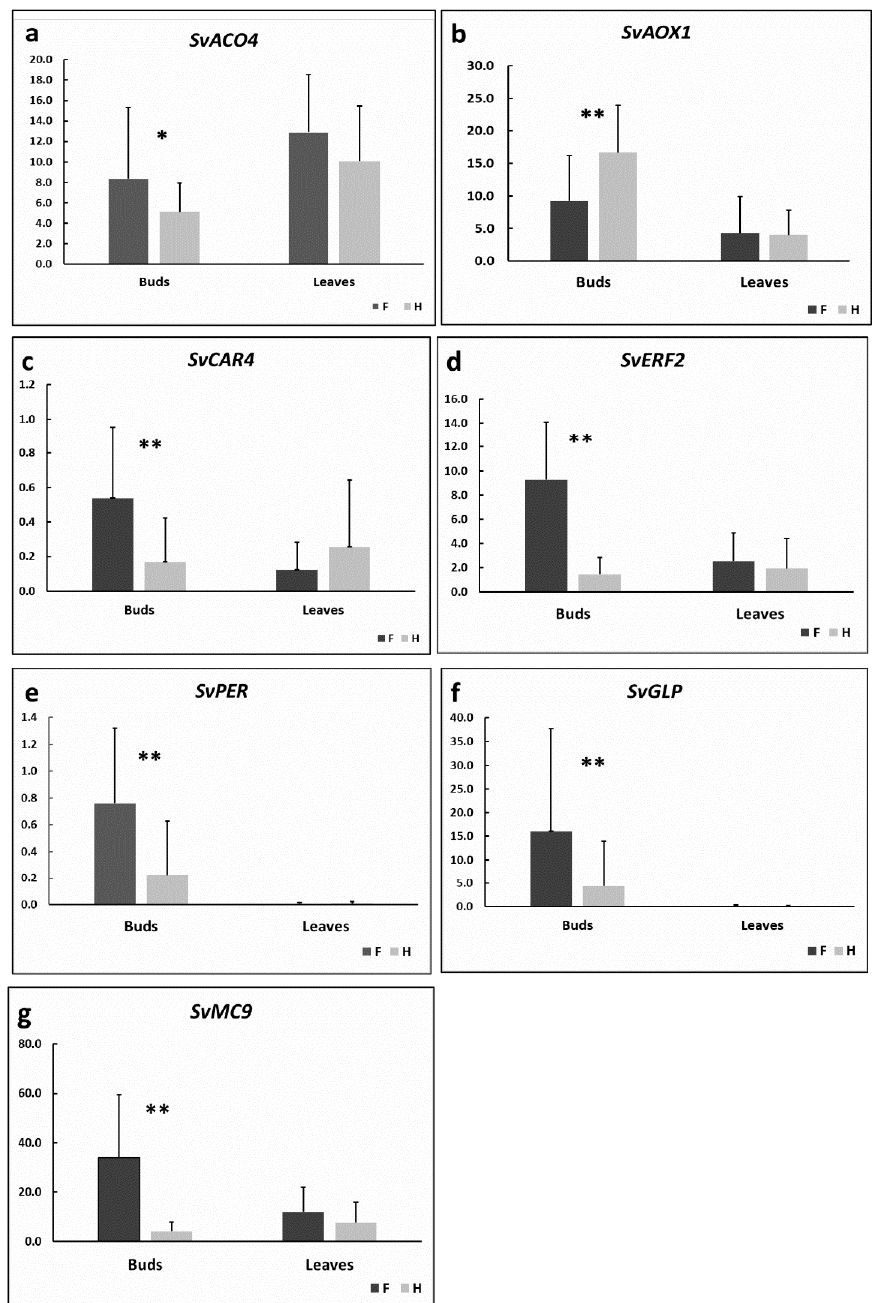
Figure 4. Relative expression estimates of selected DE genes between F and H plants of S. vulgaris . The gene coding for actin was used as a reference. Fifteen individuals of each gender were analyzed. Significant di ff erences, as estimated by ANOVA ( p < 0.05), are marked by two asterisks. The result with (0.05 < p < 0.07) is marked with a single asterisk. ( a ). SvACO4 , ( b ). SvAOX1 , ( c ). SvCAR4 , ( d ). SvERF2 , ( e ). SvPER , ( f ). SvGLP , ( g ). SvMC9 .